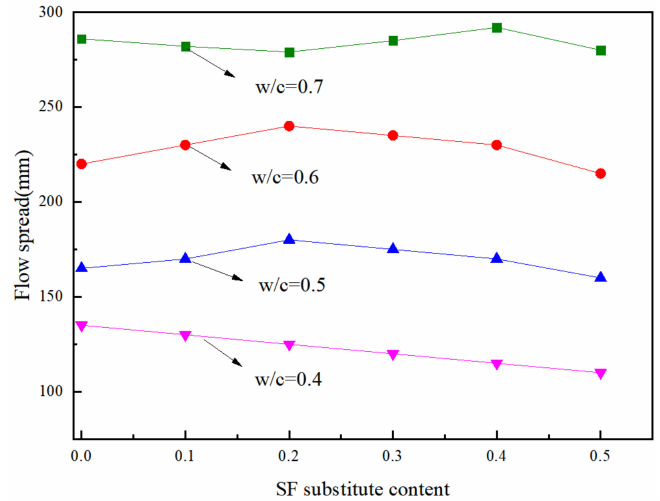
Figure 3. Variations of flow spread with w/c at different SF substitute